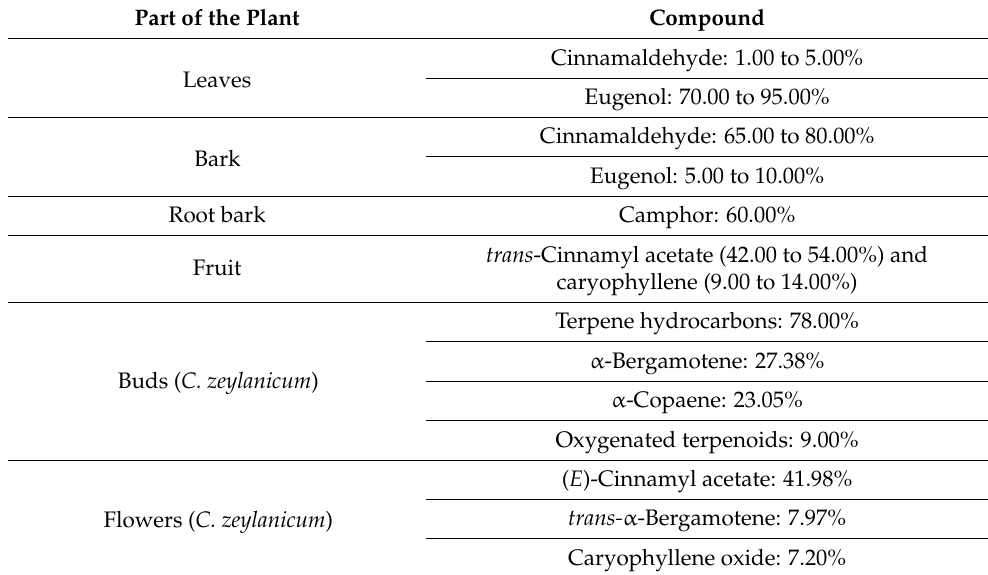
Cinnamaldehyde: 1.00 to 5.00% Eugenol: 70.00 to 95.00% Cinnamaldehyde: 65.00 to 80.00%